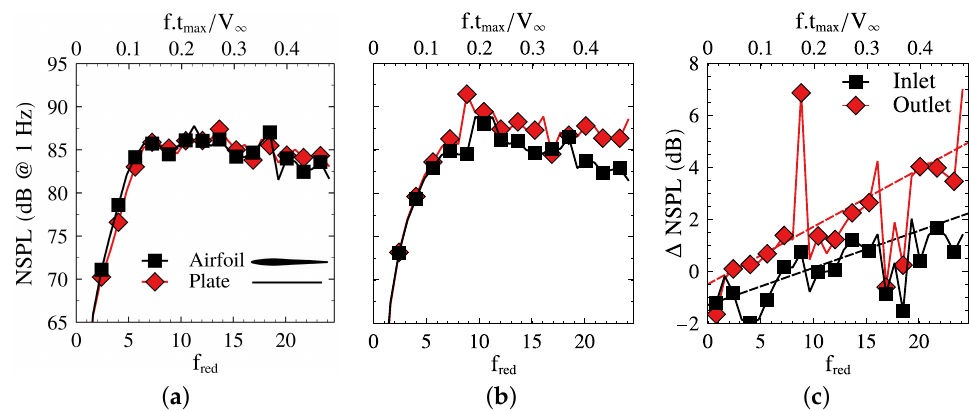
Figure 8. Assessment of the impact of zero-camber airfoil thickness on the broadband noise footprint at OP1. Subfigures ( a , b ) compare, respectively, the results with the airfoil and flat plate approximation at the inlet and outlet. Subfigure ( c ) shows the difference between both approaches at the inlet and outlet. The least-squares linear fittings are shown, given by equation: ∆ PWL = − 1.30 + 5.79 f . t max / V ∞ (inlet) and ∆ PWL = − 0.50 + 10.15 f . t max / V ∞